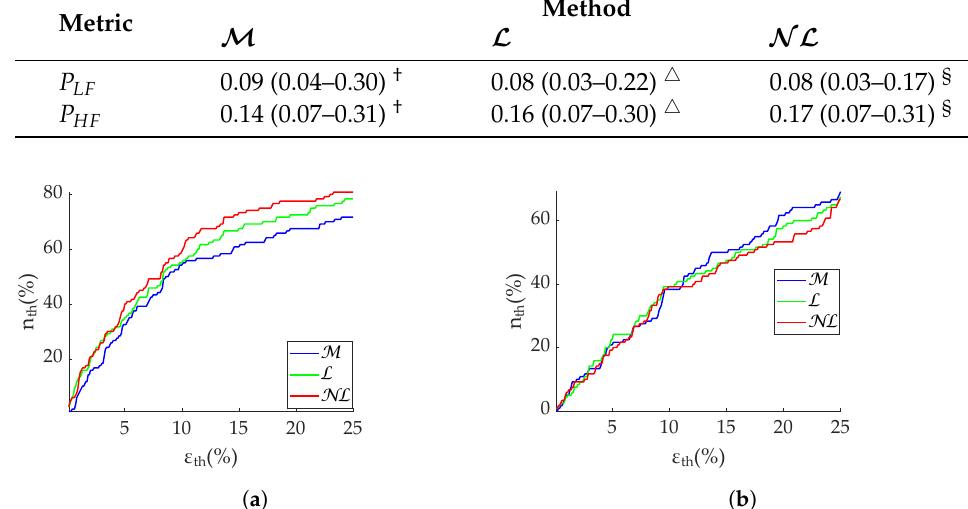
Table 6. Relative error (%) of frequency-domain metrics computed via FFT from Apple Watch dataset. †: Significant differences ( p < 0.05) between M and L . (cid:52) : Significant differences ( p < 0.05) between L and N L . §: Significant differences ( p < 0.05) between N L and M . Metric